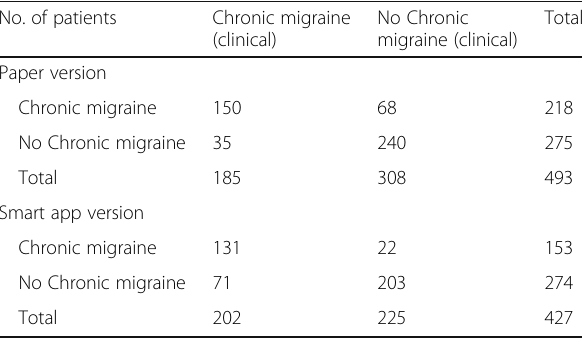
Table 3 Data matching of questionnaires and clinical diagnoses No. of